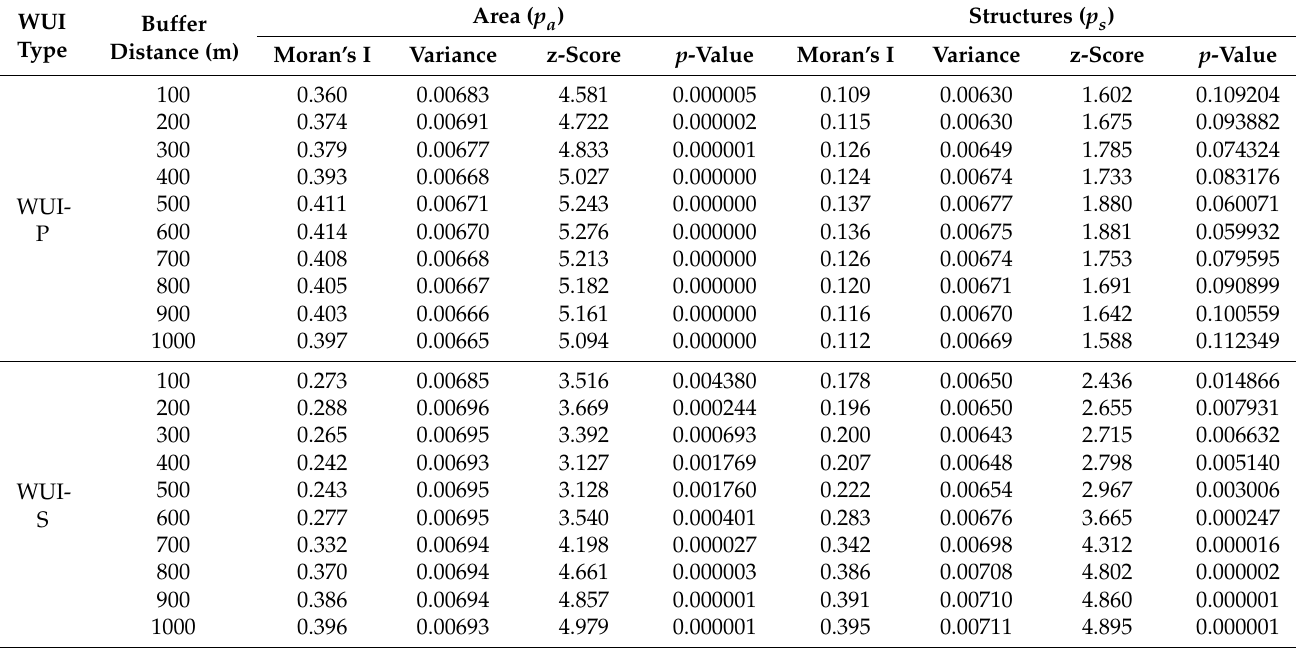
Table 5. Global Moran’s I calculation results with variance, z-score, and p